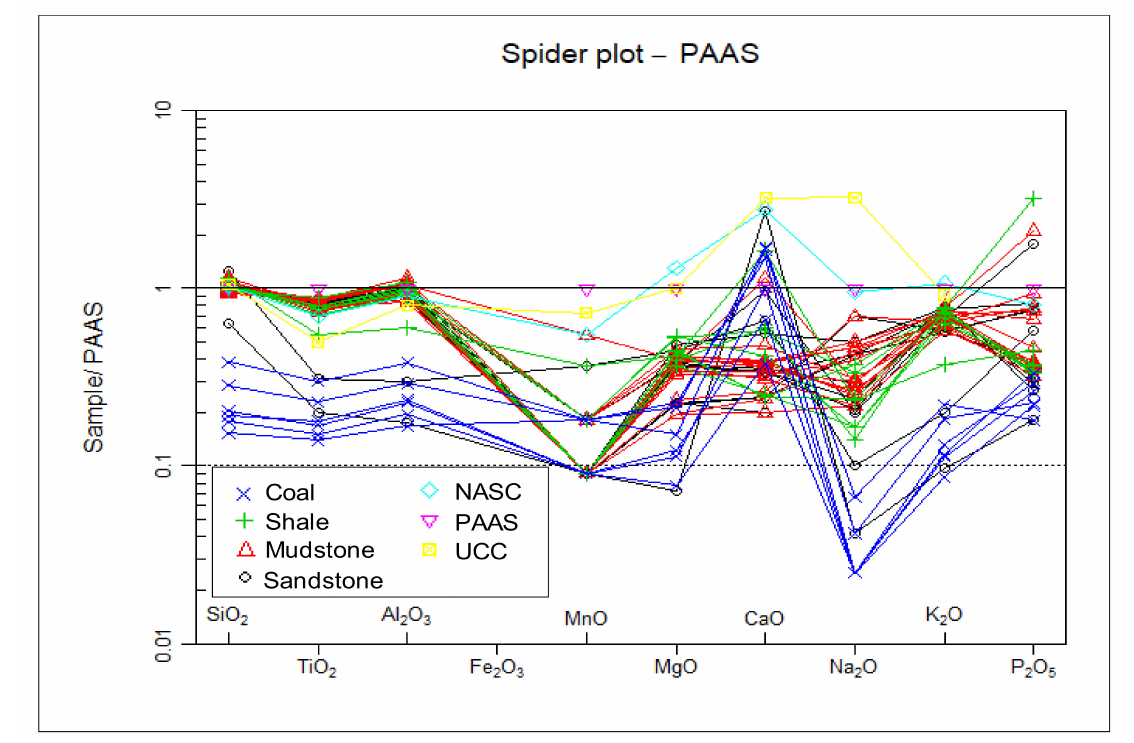
Figure 7. Multivariation diagram of oxides for the studied samples normalized against PAAS (after [26]).